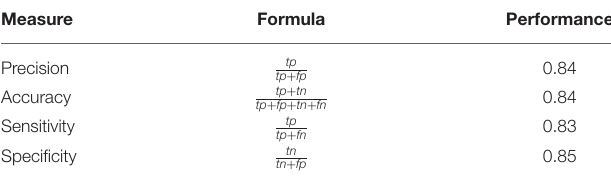
TABLE 3 | Characteristics of each